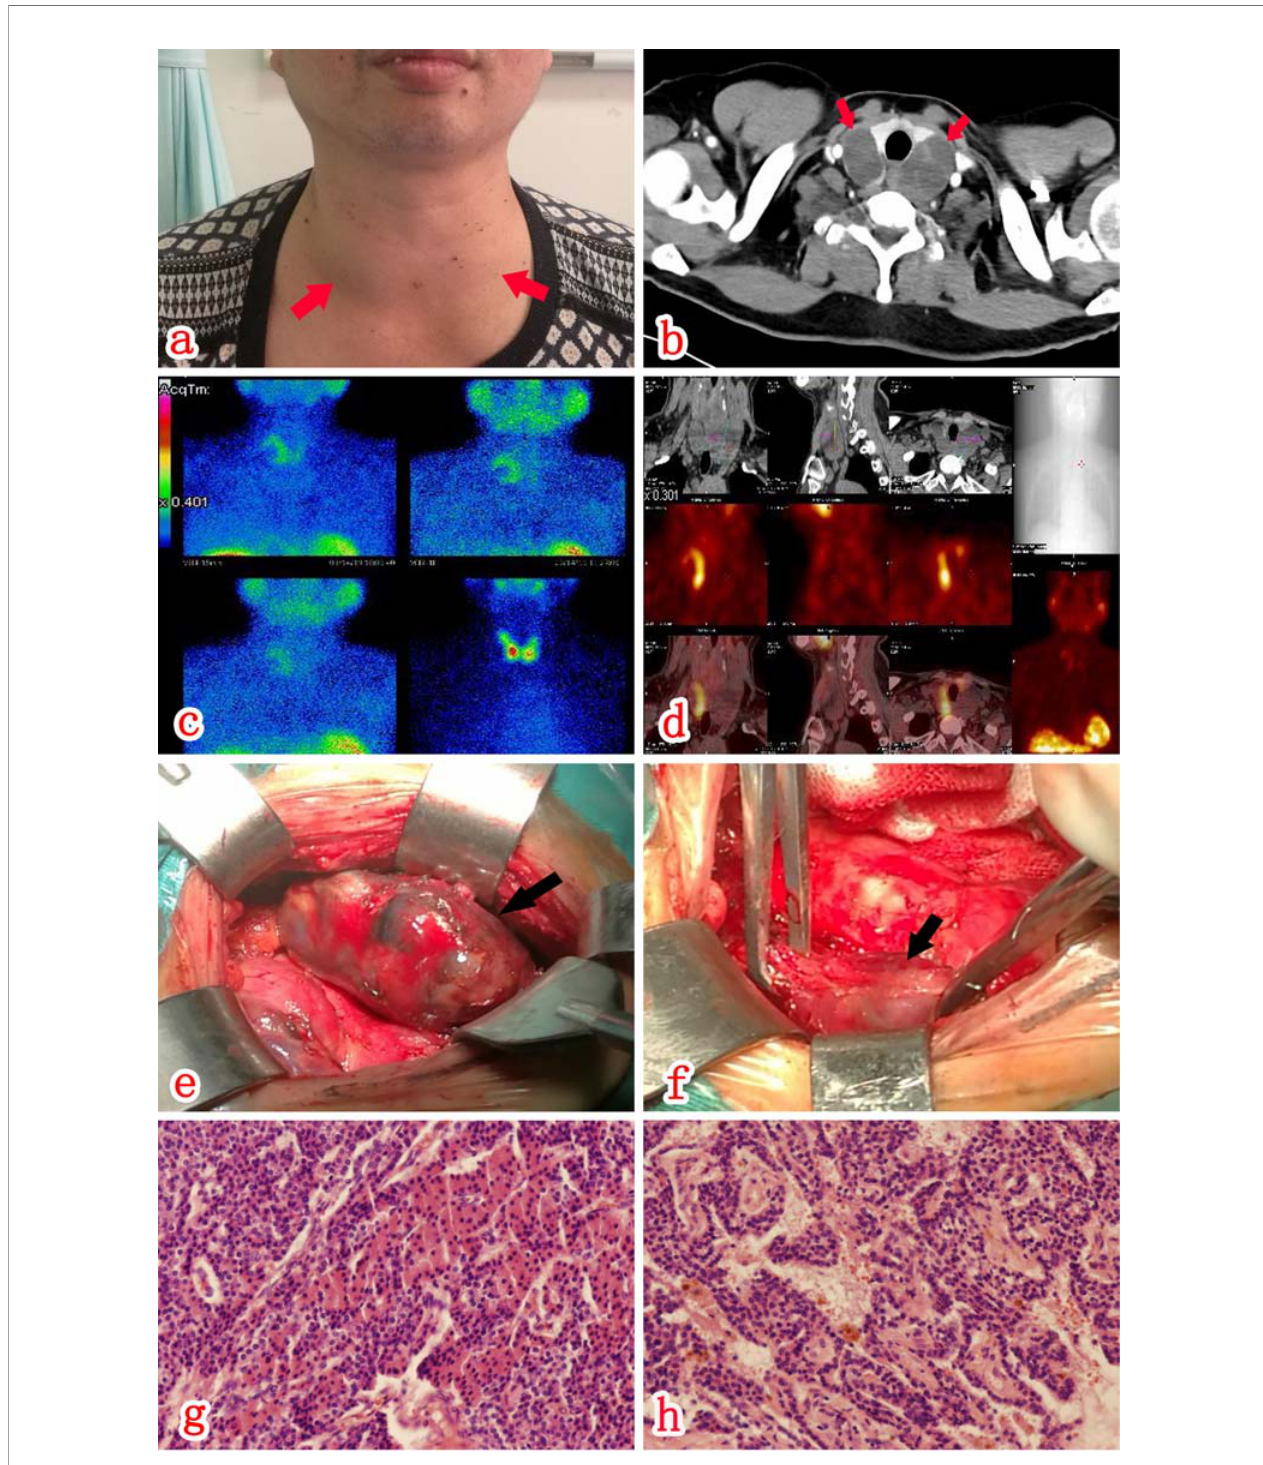
FIGURE 1 | There was a grade II goiter (A) , with a 4 x 4 cm mass palpable near the thyroid bilaterally. CT scan (A, B) of the neck revealed bilateral slightly hypointense cystic shadows below the thyroid. SPECT/CT fusion imaging (C, D) revealed an abnormal increase in uptake in part of the mass behind the right lobe of the thyroid during MIBI, which was considered relevant to hyperparathyroidism. There were a cystic-solid mass (E) on the posterolateral aspect of the right lateral lobe of the thyroid and a cystic-solid mass (F) on the left lateral lobe of the thyroid. Postoperative paraf fi n pathology (HE staining x100) results indicated that both the right (G) and left (H) space-occupying lesions represented parathyroid adenomas with cystic